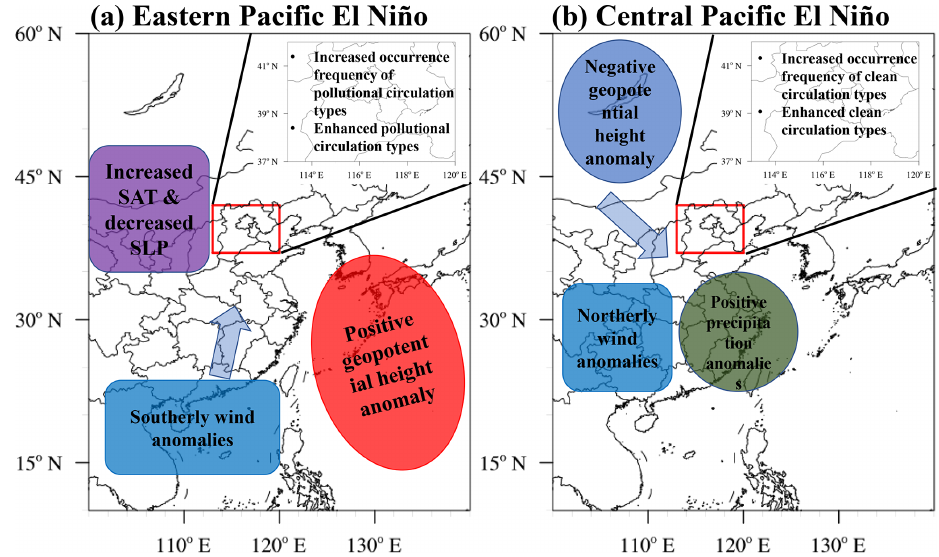
Figure 8. Schematic diagrams showing the physical mechanisms of the effects of (a) eastern Pacific and (b) central Pacific El Niño on WHDs in the JJJ